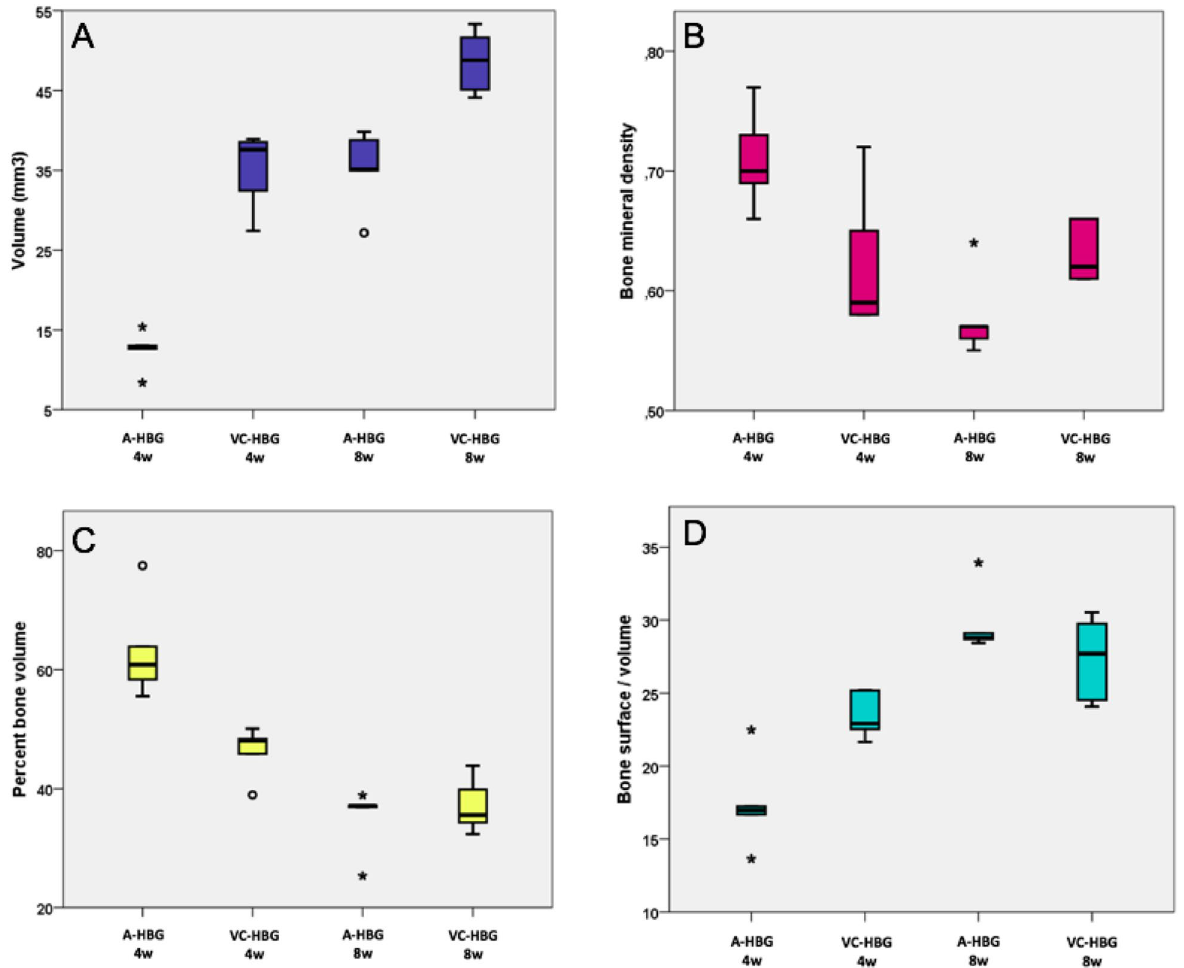
Figure 1. Association between bone volume gain (mm 3 ) ( A ), bone mineral density (BMD) ( B ), percentage of bone volume ( C ), bone surface/total volume ratio ( D ) and graft type at each time point. A-HBG acellular-human bone graft, VC-HBG viable cryopreserved-human bone graft.